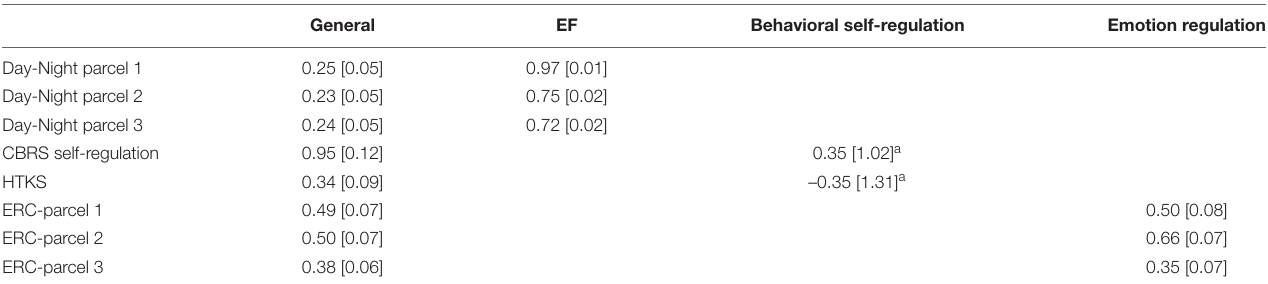
FIGURE 2 | Tested bifactor model self-regulation. TABLE 2 | Standardized factor loadings from the bifactor